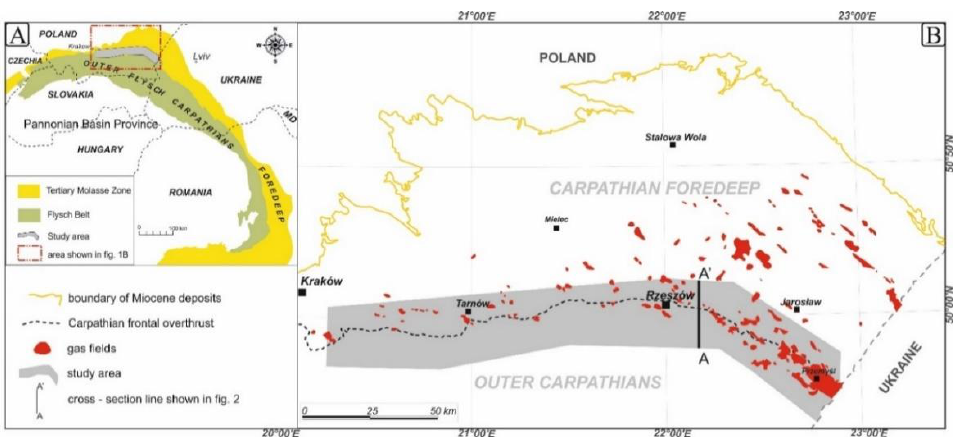
Figure 1. ( A ) General outline map of Carpathian Foredeeep (after [22], modified), with ( B ) location of gas fields in the study area (after [23], modified).